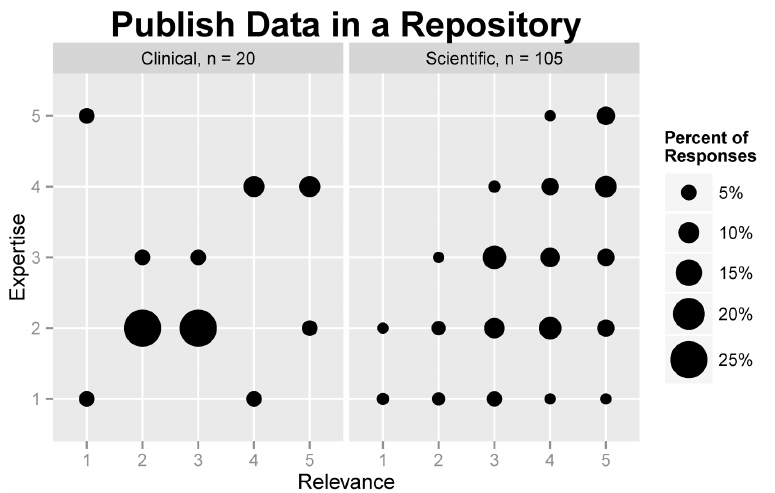
Fig 2. Comparison of self-rated relevance and expertise regarding sharing data in a repository among clinical and scientific research staff.